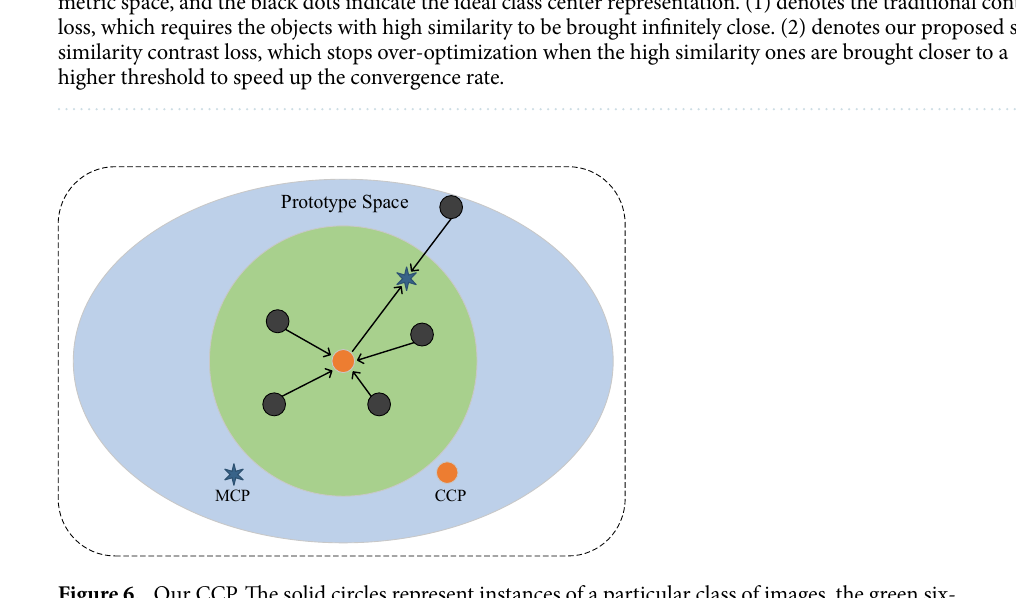
Figure 6. Our CCP. The solid circles represent instances of a particular class of images, the green six- pointed stars represent the mean class prototype, and the orange solid circles represent the cumulative class prototype. The extreme values outside the large circle pull the mean class prototype away from the class center while the cumulative class representatives near the class center have larger similarity values to serve as class